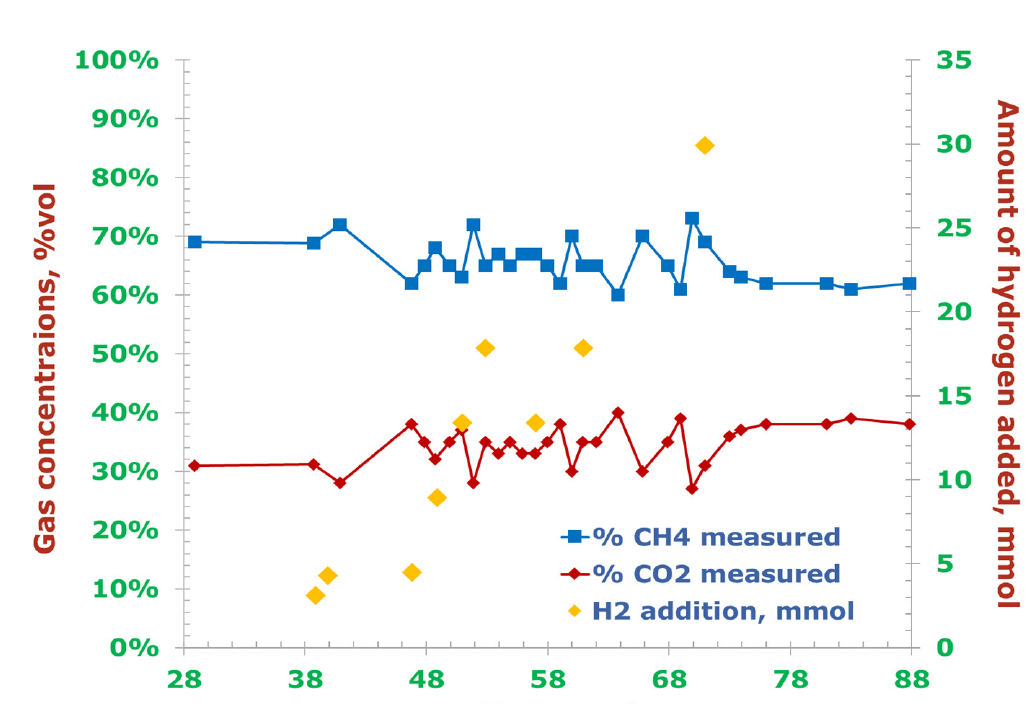
Figure 2. Effect of H 2 injection on biogas composition ( v / v ) in terms of standard temperature and pressure (STP) normalized CH 4 and CO 2 contents.